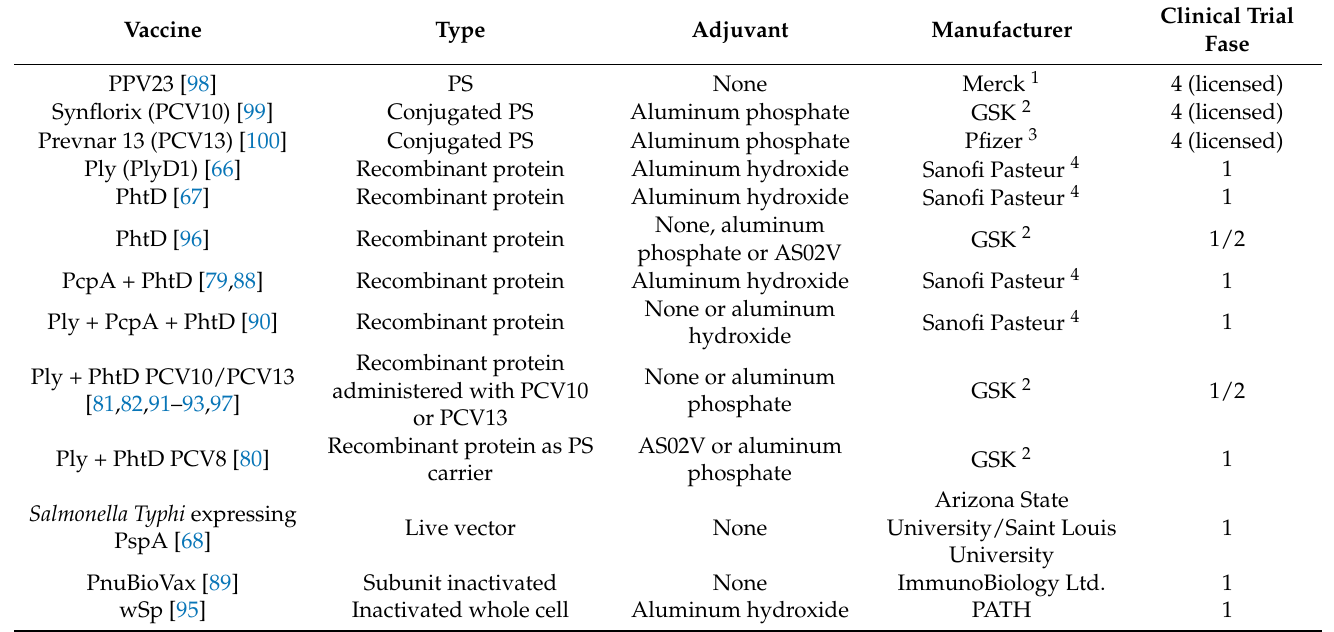
Table 1. Pneumococcal vaccines: vaccines licensed and in clinical